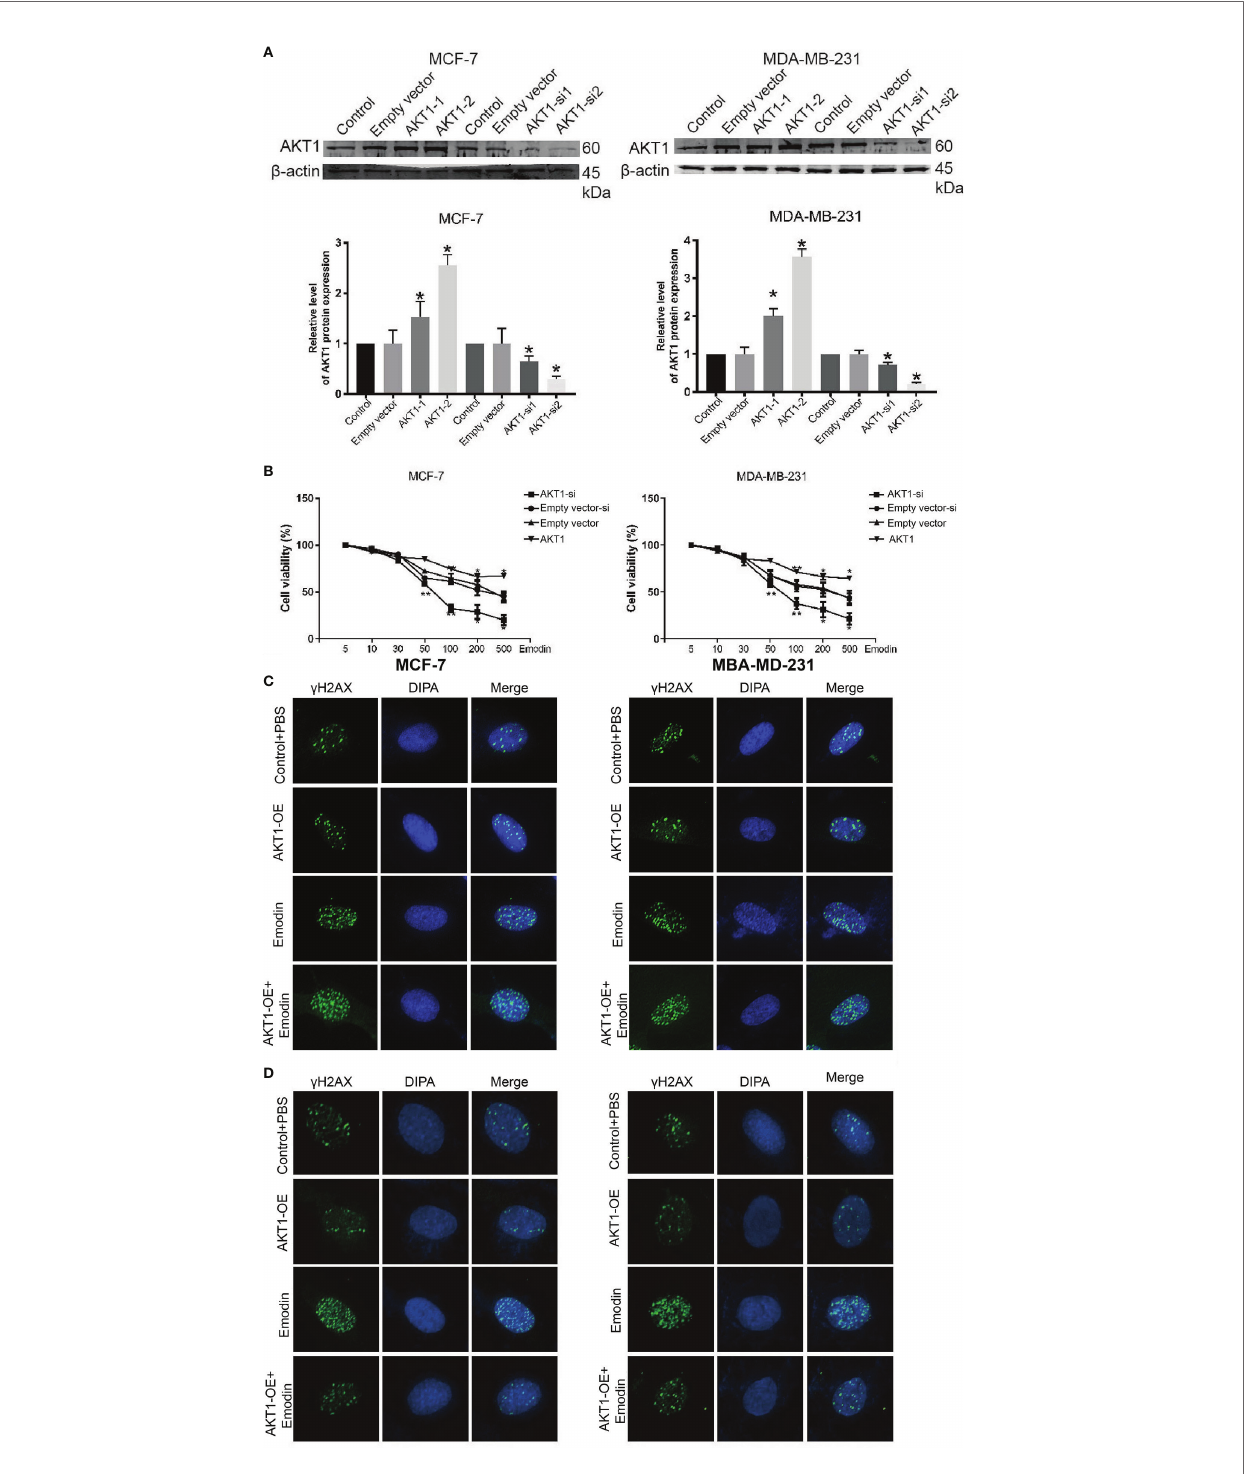
FIGURE 7 | BC cells complemented with AKT-1-si or AKT-1-oe regulated to Emodin. (A) The expression of AKT1 after treatment with AKT1-siRNA or AKT1 overexpression. (B) CCK-8 assay shows the BC cells complemented with AKT1-siRNA or AKT1 over-expression. (C) DNA damage assays shows that the BC cells complemented with AKT1-siRNA promote Emodin compared with cells treated with AKT1-siRNA or Emodin alone. (D) DNA damage assays shows that the BC cells complemented with AKT1 over-expression resists Emodin compared with cells treated with AKT1-overexpression or Emodin alone. The analysis was conducted using the Student ’ s t-test. p > 0.05, **p < 0.01, *p <